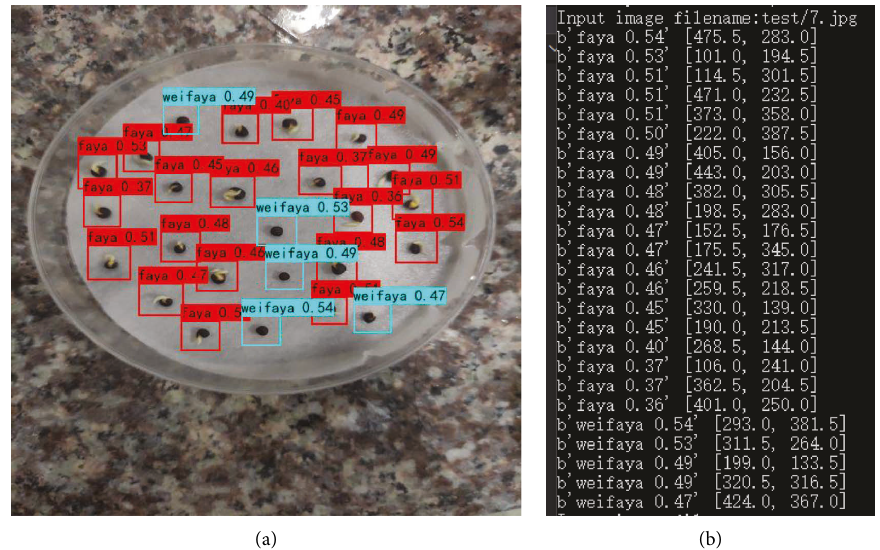
Figure 8: Improved CenterNet algorithm recognition results. (a) Identified target. (b) Score and center position (without overlapping